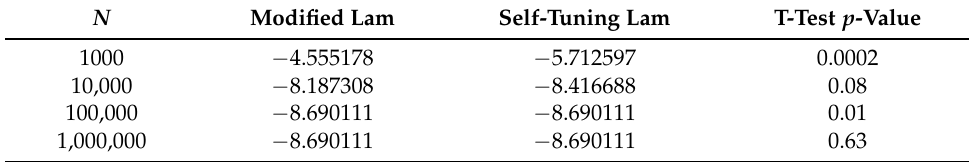
Table 16. Average solution for minimizing g 10 ( x ) . The minimum is g 10 ( x ) ≈ − 8.69011. N